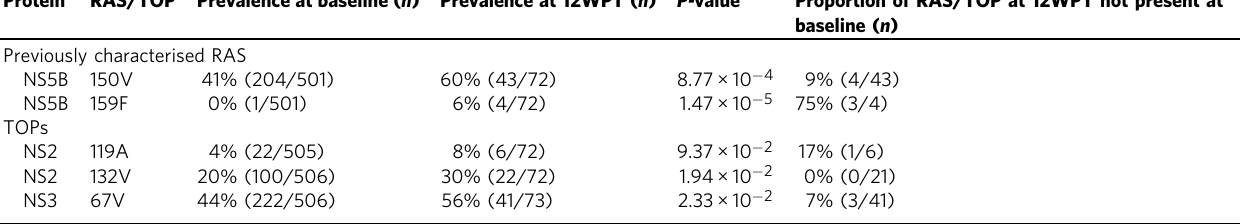
The percentage of the population with each RAS or TOP is shown at baseline and 12WPT. These distributions were compared usinga one-sided binomial test and the P -valueis shown (nominal P -value, not adjusted for multiple comparison). The percentage of patients where the amino acid at baseline has changed to the RAS or TOP in post-treatment sequence is also